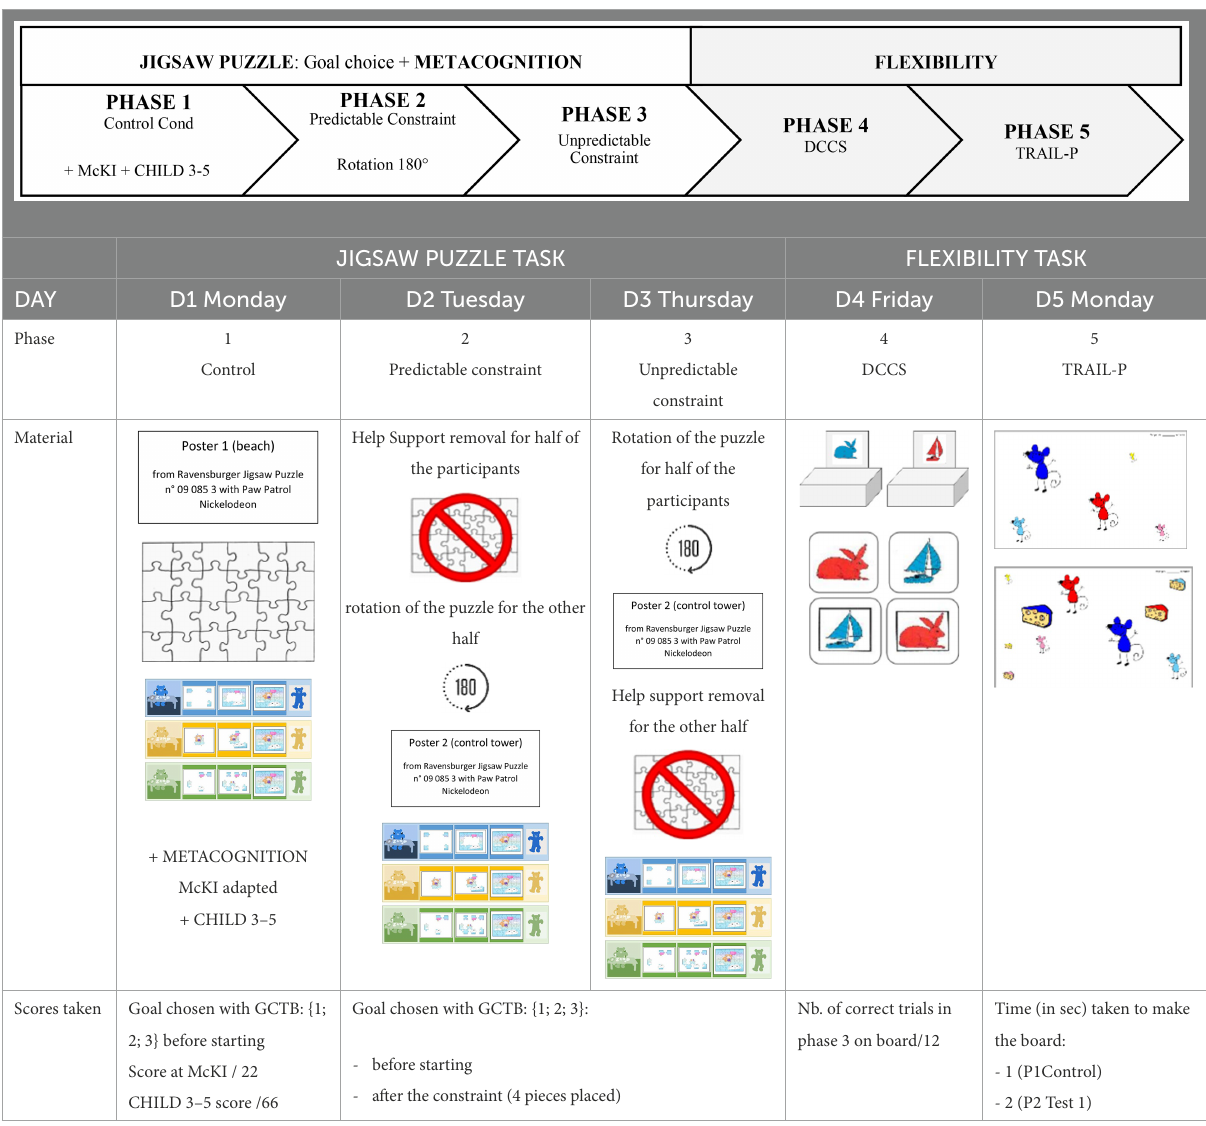
TABLE 1 Typical timeframe of